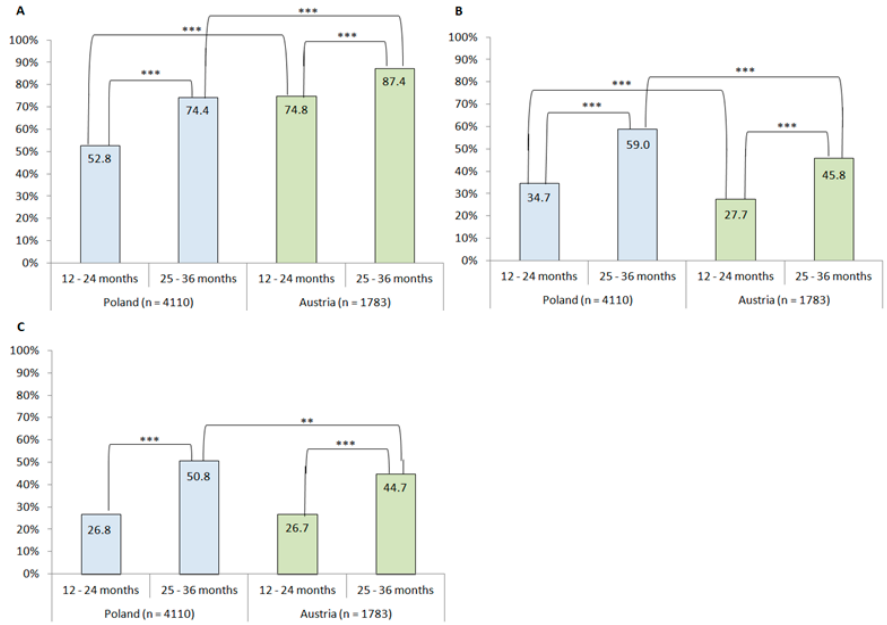
Figure 2. Use of added salt ( A ), sugar ( B ), both salt and sugar ( C ) in toddlers’ diets according to country and age group; ** p ≤ 0.01; *** p ≤